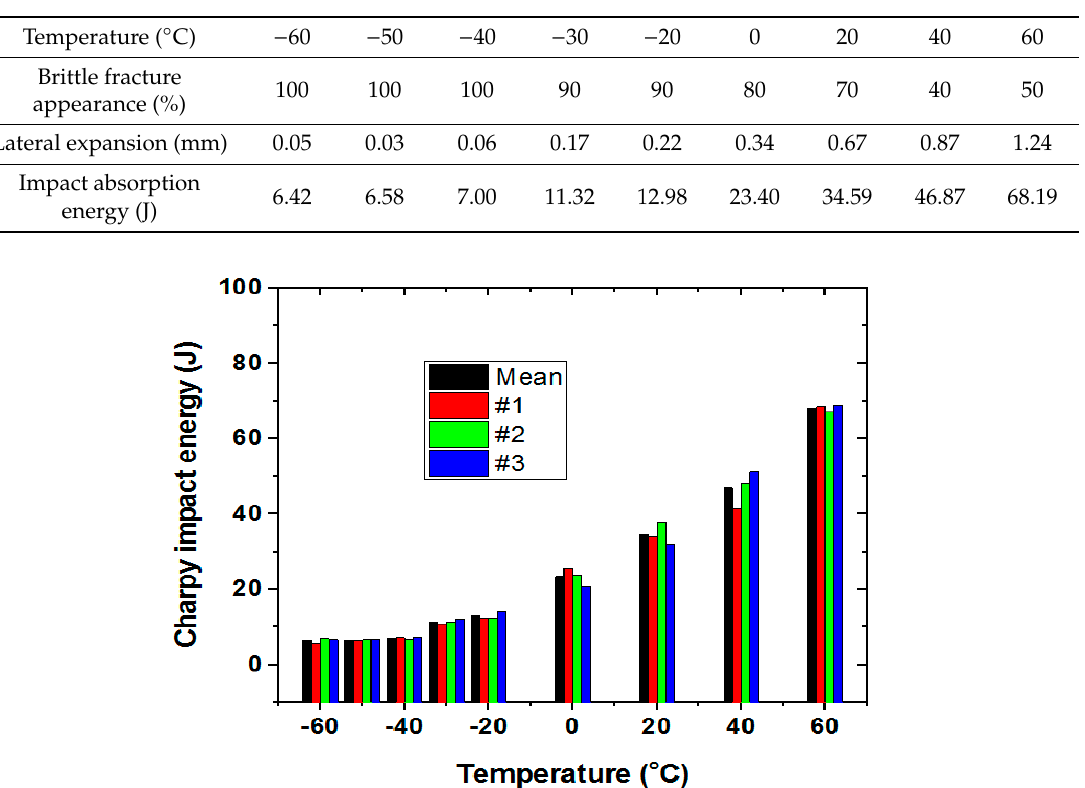
Figure 10. Charpy impact absorption energy.